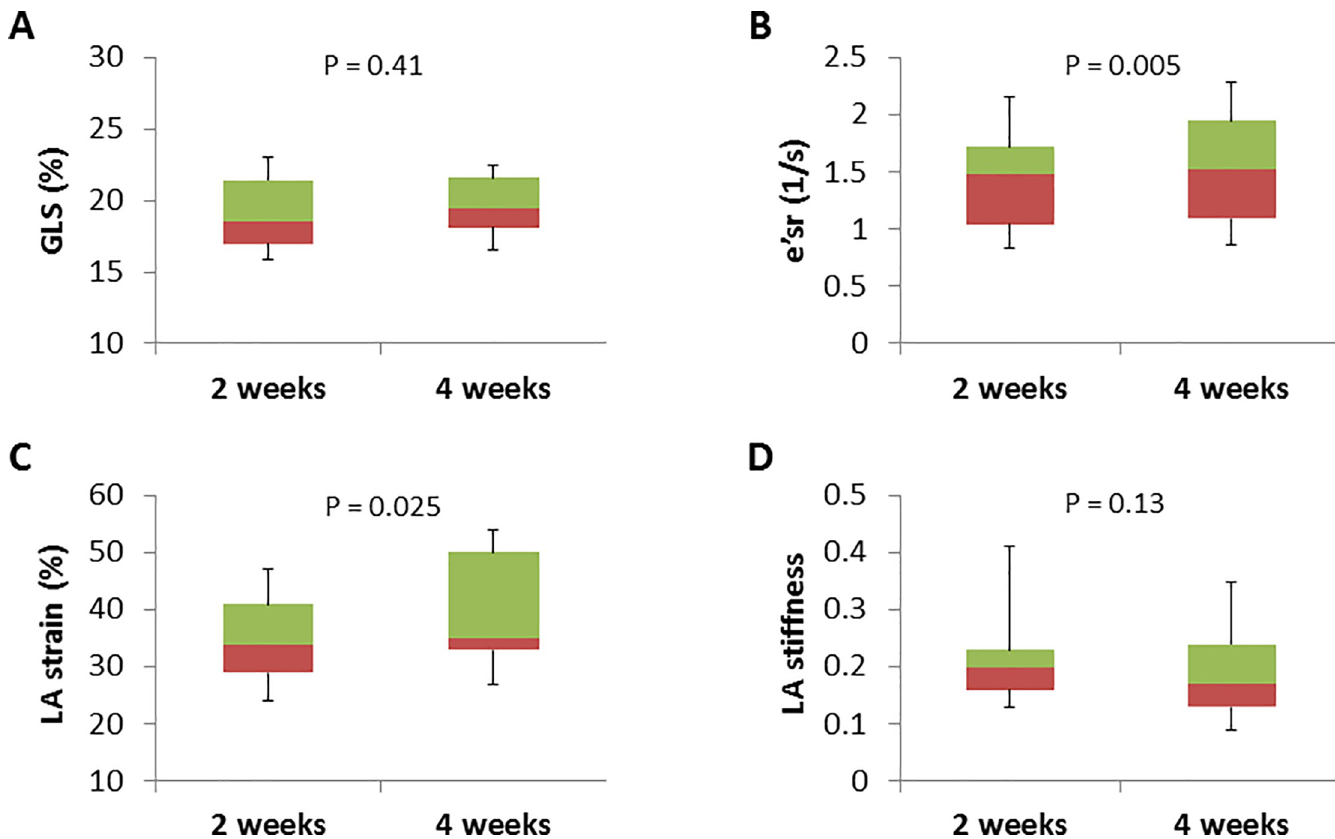
Fig 2. Comparisons of the STE-derived variables at 2 and 4 weeks after diagnosis of